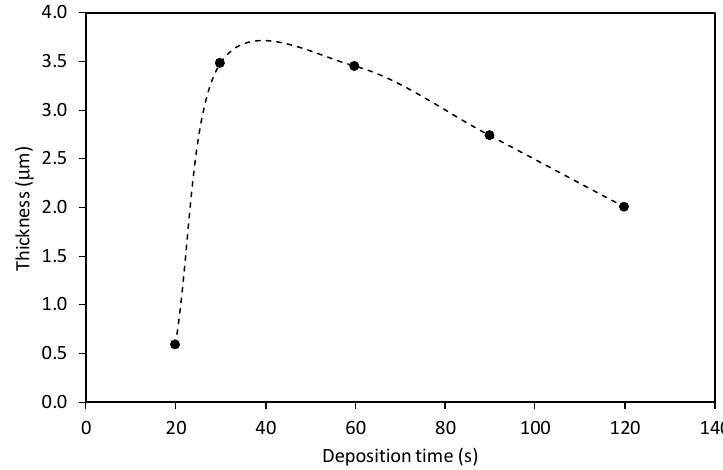
Figure 3. The thickness of CNWs, shown in Figure 2, versus deposition time.